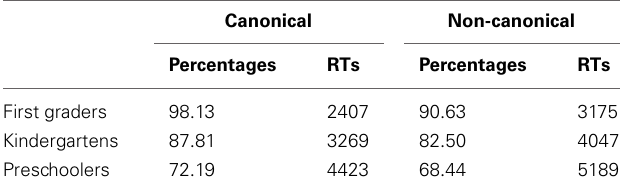
Table 4 | Percentages of correct responses and reaction times (in ms) in the identification of finger numerical pattern task as a function of school levels and finger